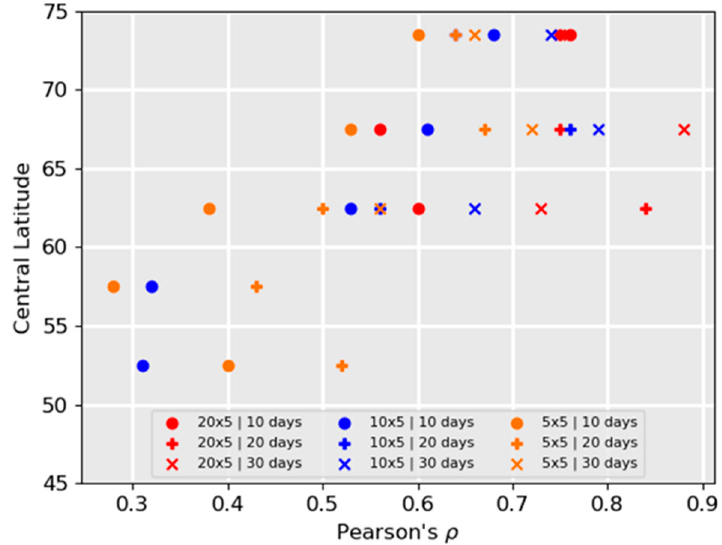
Figure 7. Correlation coefficients of collocated ∆ SWE B and ∆ SWE C datasets at the nine spatiotemporal resolutions considered in this study, subset by latitude ranges. Data are plotted at the central latitude of a grid cell. Data points are only included at a given central latitude if measurements exist and if the p value corresponding to the correlation coefficient of the measurements is less than 0.01.